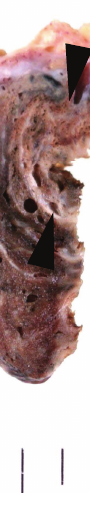
Figure 5: Simple pulmonary aspergilloma. There is a preexisting cavity (black arrow head) and few changes surrounding the